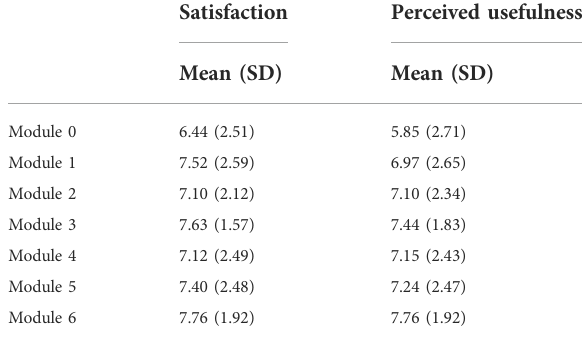
TABLE 5 Mean and standard deviations on treatment satisfaction scale a .